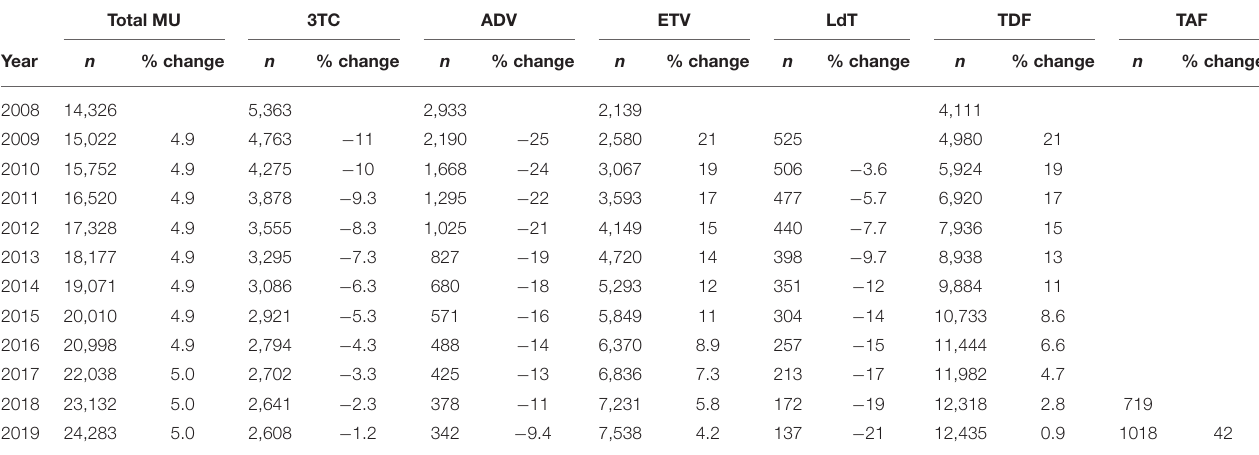
MU, monthly units representing number of individuals treated; 3TC, lamivudine; ADV, adefovir; ETV, entecavir; LdT, telbivudine; TDF, tenofovir disoproxil fumarate; TAF, tenofovir alafenamide.